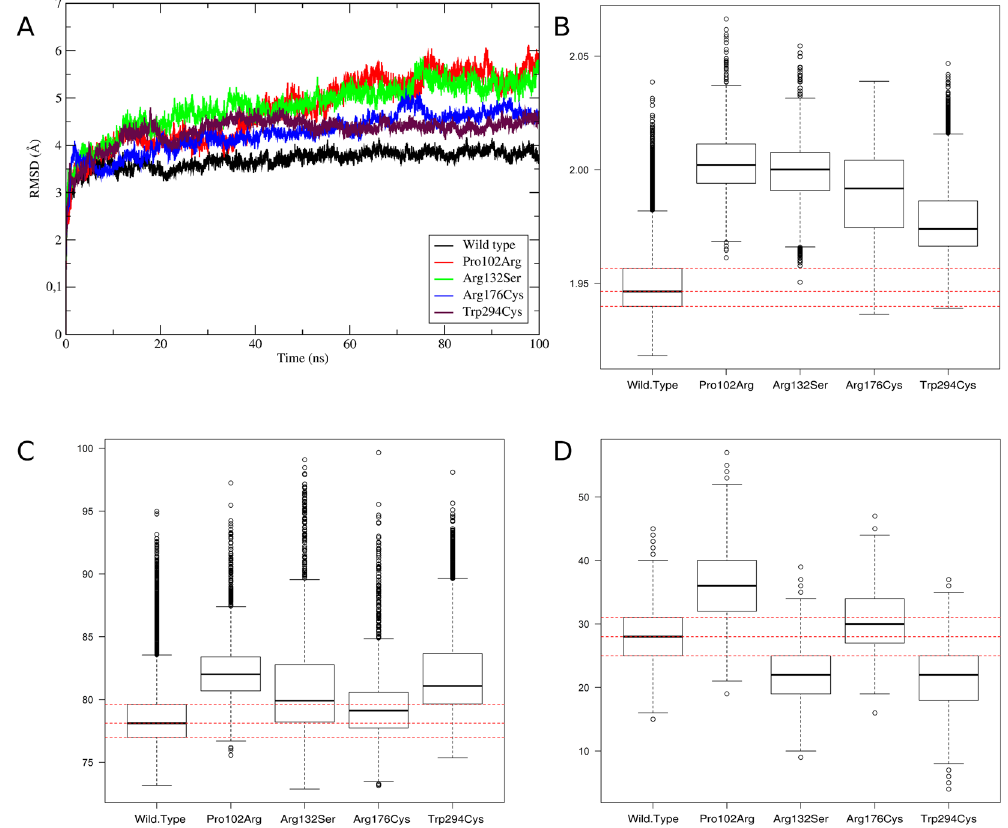
Figure 3. ApoE3 native and variants trajectories analyses. In Backbone RMSD variation the variants are identified in the plots by different colors ( A ). Radius of gyration ( B ), solvent accessible surface area ( C ) and number of hydrogen bonds ( D ) are plotted in boxplots. On backbone RMSD ( A ) the variants are identified in the plots by colors: Native structure (black), Pro102Arg (red), Arg132Ser (green), Arg176Cys (blue) and Trp296Cys (turquoise). Only the number of hydrogen bonds between NT and CT domains was computed ( D ). Dotted red lines on solvent accessible surface area, radius of gyration and number of hydrogen bonds plots indicate the reference values of wild type. The solvent accessible surface and radius of gyration values are in nm² and to RMSD values in